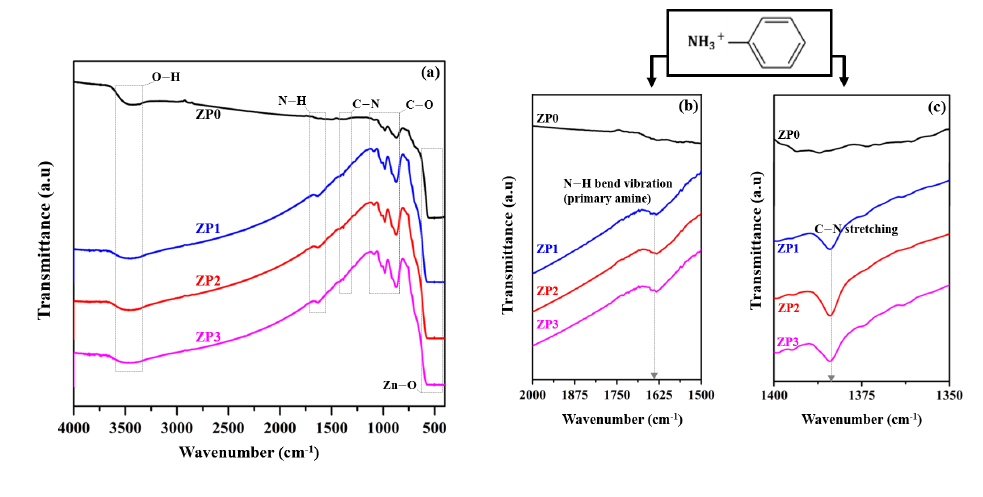
Figure 1. FT-IR of zinc oxide (ZnO) and polyaniline (PANI)-functionalized ZnO samples: ( a ) 400– 4000 cm − 1 , ( b ) N-H bending mode region: 1500–2000 cm − 1 , and ( c ) C-N stretching mode region: 1350–1400 cm − 1